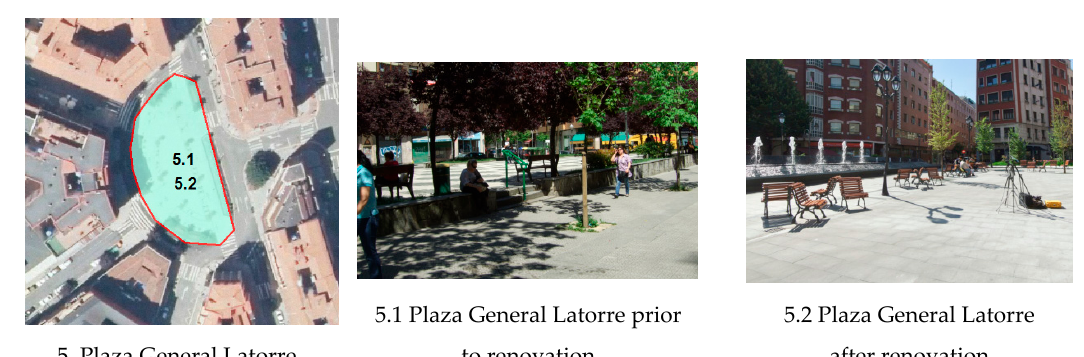
Figure 1. Images of the five public spaces and specific analysed units.